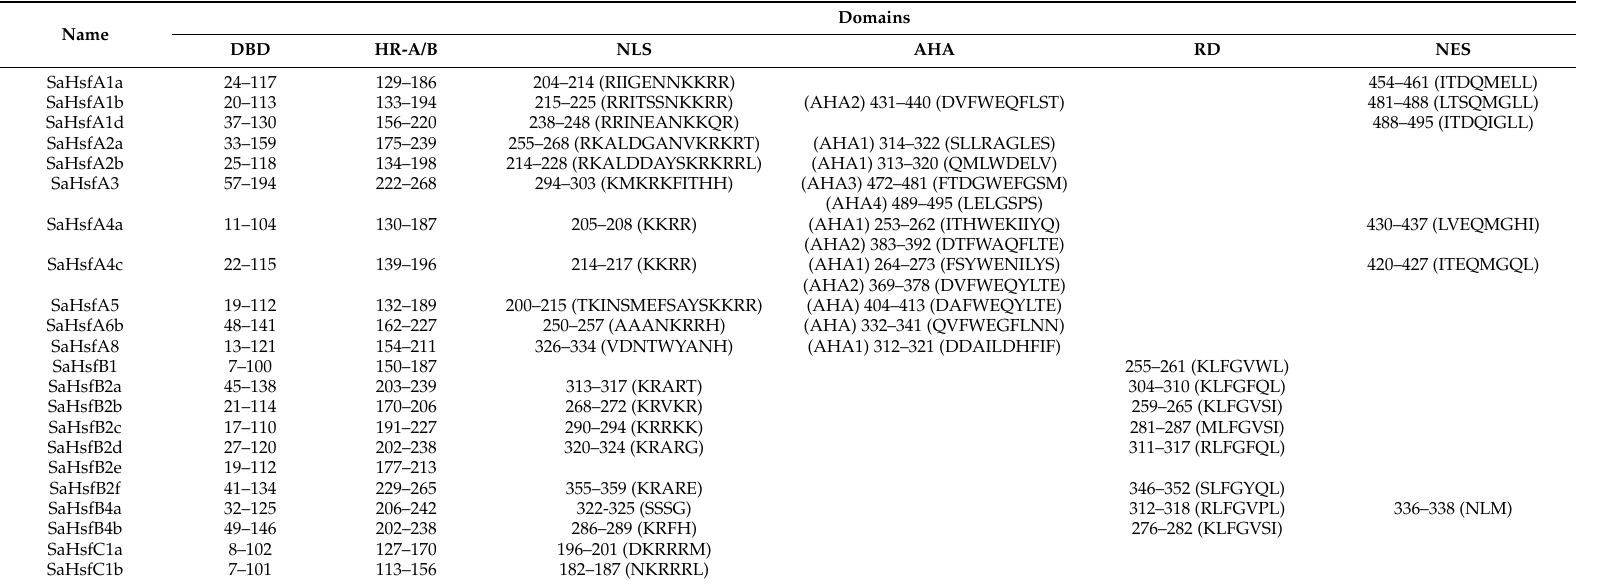
Table 3. Function domains found by HEATSTER in